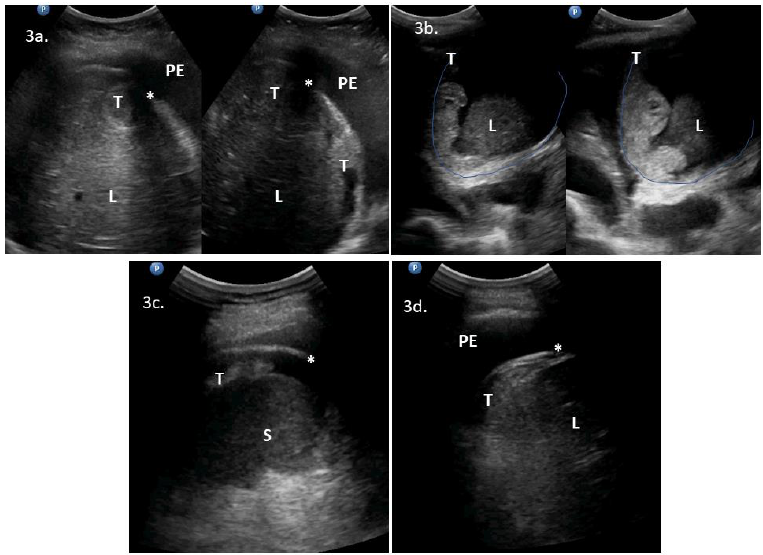
Figure 2. Lung ultrasonograms of lesions on the pleural diaphragmatic surface: ( 2a ) nodules on the right diaphragmatic pleural surface and pleural effusions; ( 2b ) pleural nodules and pleural effusions on the left side; and ( 2c ) ( 2d ) Bulky tumors on the right diaphragmatic pleural (and abdominal) surface and pleural effusions. Abbreviations: (*) diaphragm; (A) ascites; (L) liver; (PE) pleural effusions; (S) spleen; (T) tumor. Comment: The diaphragm is seen as a “bright line” and indicates the reflection between the air-filled lung and adjacent tissues. A normal diaphragm is 3–10 mm thick in the costal part and in the crus, respectively.